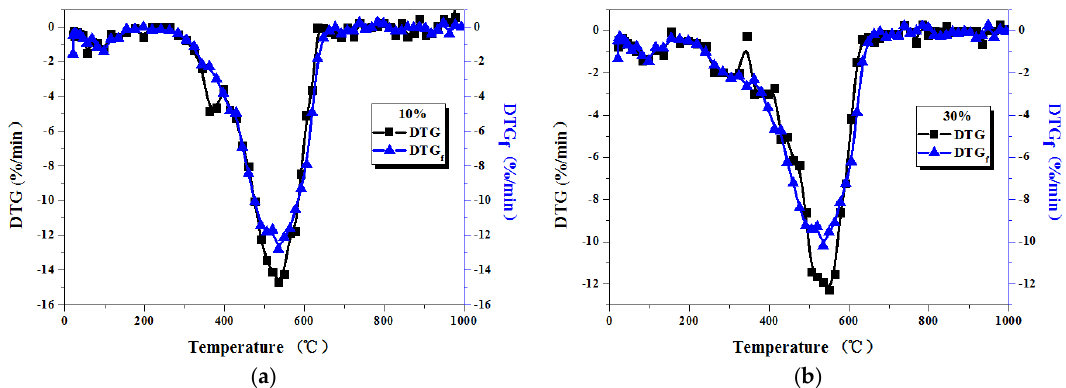
Figure 5. Actual and fitted DTG curves for coal-sludge (S 3 ) blends of different dried sludge weight percentages (heating rate = 30 °C/min) (( a ) 10%; ( b ) 30%).